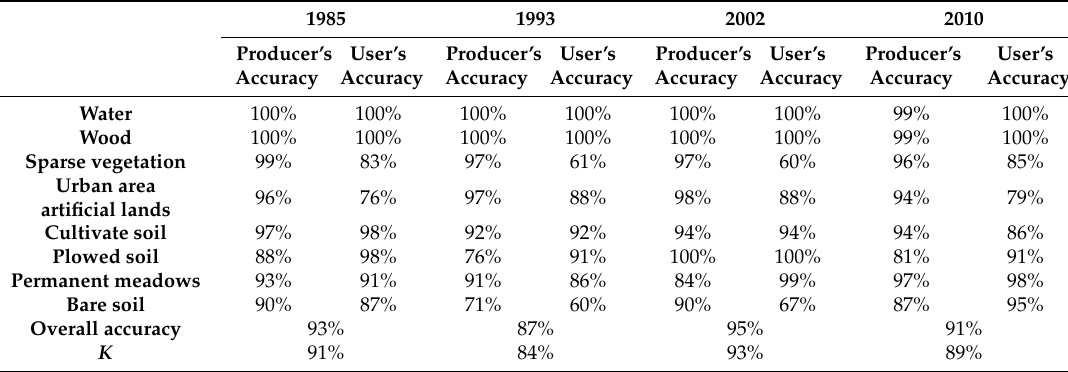
Table 3. Accuracy of the classification of Landsat data (%) in 1985, 1993, 2002 and